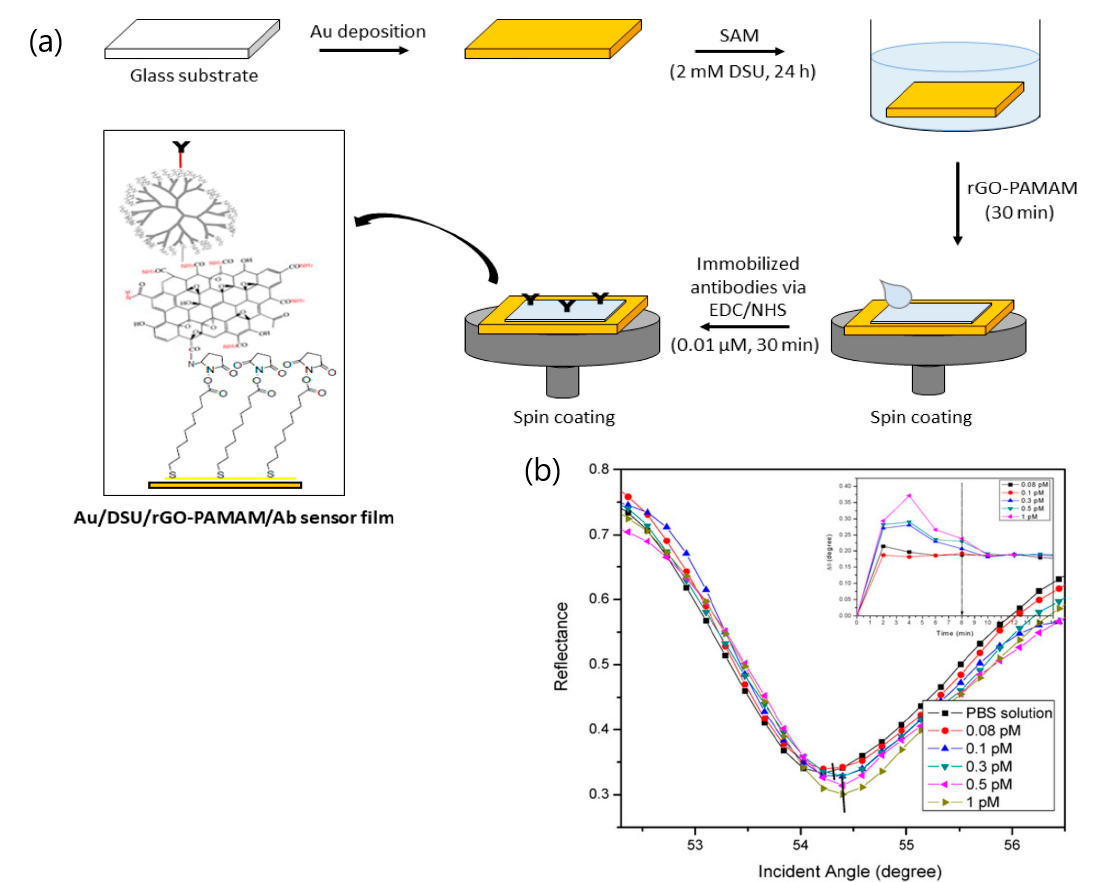
Figure 10. ( a ) Preparation procedure of the sensor film. SAM: Self-assembled monolayer, EDC:N- ethyl-N-(3-(dimethylaminopropyl) carbodiimide, NHS: N-hydroxysuccinimide, DSU / rGO–PAMAM: dithiobis (succinimidyl undecanoate) / reduce graphene oxide–polyamidoamine; ( b ) SPR reflectance of the SPR sensor based on a DSU / amine-functionalized rGO–PAMAM / IgM sensor film. Inset: SPR time response upon introduction of 0.08 to 1 pM of dengue virus (DENV 2) E-proteins. Adapted with permission from Omar et al. [50] Copyright © (2020) MDPI (under the terms and conditions of the